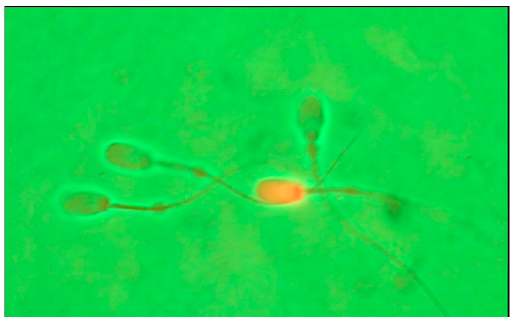
Figure 2. Assessment of plasma membrane integrity. Red stained sperm corresponding to dead sperm and non-red stained corresponding to sperm with intact plasma membrane